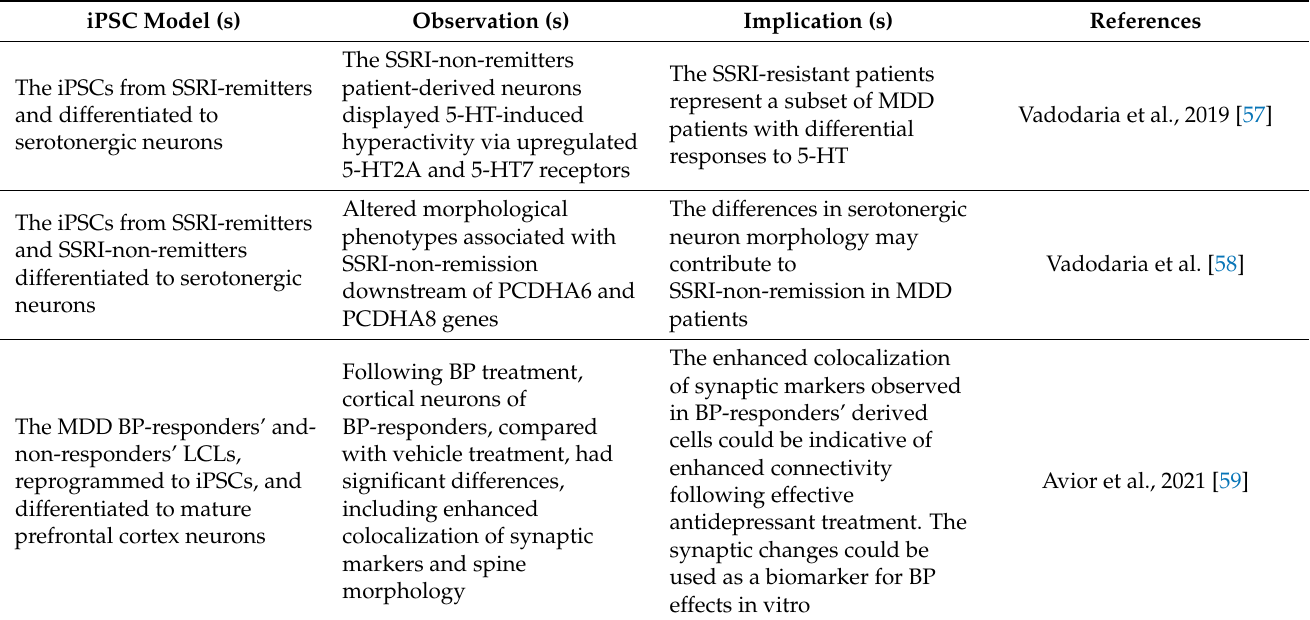
Table 2. Selected studies investigating major depressive disorder using iPSCs from